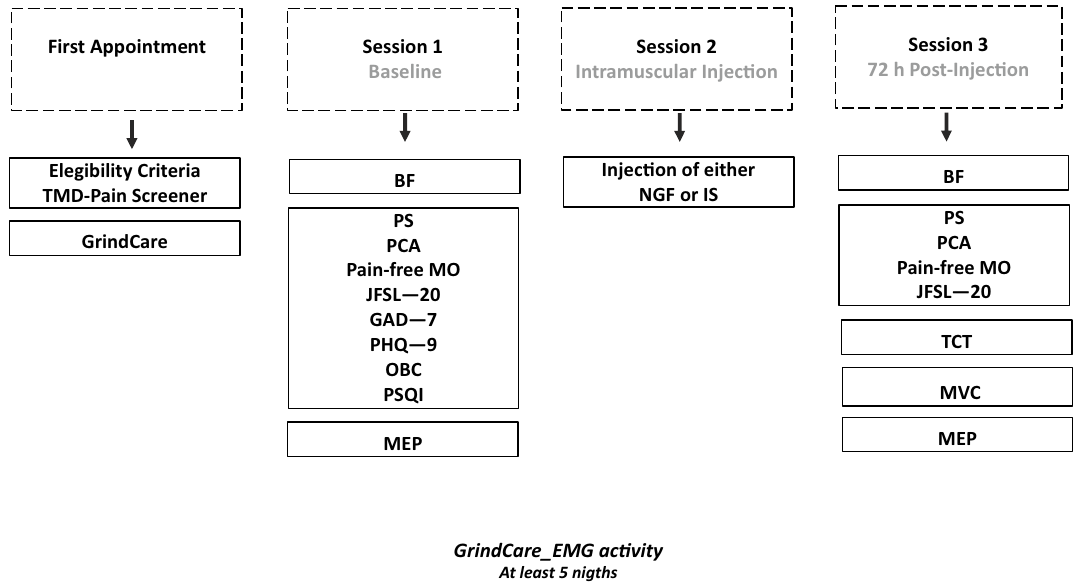
Figure 5. Study timeline: (i) First appointment , participants were interviewed about eligibility criteria, adequately instructed and trained for using the electromyographic (EMG) device (GrindCare) during sleep for at least five consecutive nights during the experiment, i.e., at least 48 h before and 72 h post-either NGF or IS injection administration, and answered the TMD—Pain Screener; (ii) Session 1 , motor evoked potential (MEP), bite force (BF) and pain ‐ free mouth opening (MO) were assessed, and also participants answered questions about jaw pain and function, i.e., Pain Scale (PS), Perceived Chewing Ability (PCA), Jaw Function Limitation Scale—20 (JFSL—20), Generalized Anxiety Disorders (GAD—7), Patient Health Questionnaire—9 (PHQ—9), Oral Behavior Checklist (OBC), and Pittsburgh Sleep Quality Index (PSQI); (iii) Session 2 (24 h after session 1), participants received either injection of nerve growth factor (NFG) or isotonic saline (IS, control) in the right masseter muscle randomly assigned; (iv) Session 3, (72 h post-either NGF or IS injection), participants performed a tooth clenching task (TCT) of three series in a randomized order for a total of 58 min, and again, MEP, BF, maximum voluntary contraction (MVC) and pain ‐ free MO were assessed and participants answered the PS, JFLS—20 and PCA